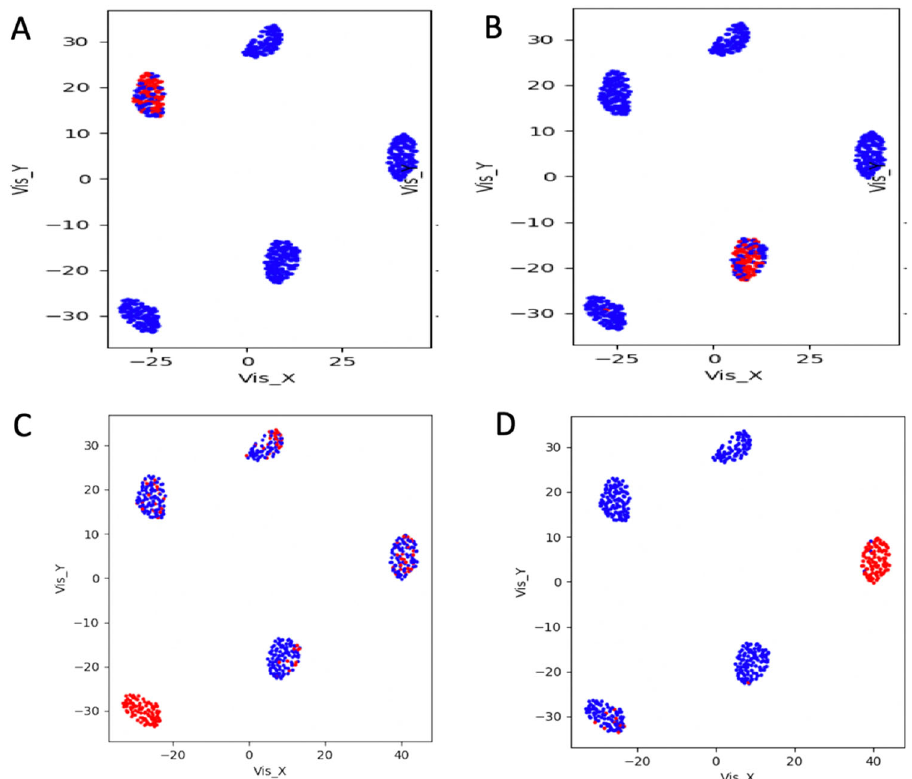
Fig. 3 COMET analysis of latent space frequency matrix. a Set of 4 genes (PAX5, NFAT5, RFXANK and CHD4) characterizing cluster 1 (B cells). b Set of 4 genes (CEBPA, KHSRP negation, CEBPB, CREBBP) characterizing cluster 2 (Monocytes). Dots are cells, blue and red color indicate, respectively, false and true positives (for more information on this type of visualization of cluster speci fi c markers see the COMET paper 21 . c Rank 1 NK signature 32 speci fi cally characterizing cluster 4 (NK). d Rank 2 Asthma KEGG negation, speci fi cally characterizing Naïve T cells (Cluster